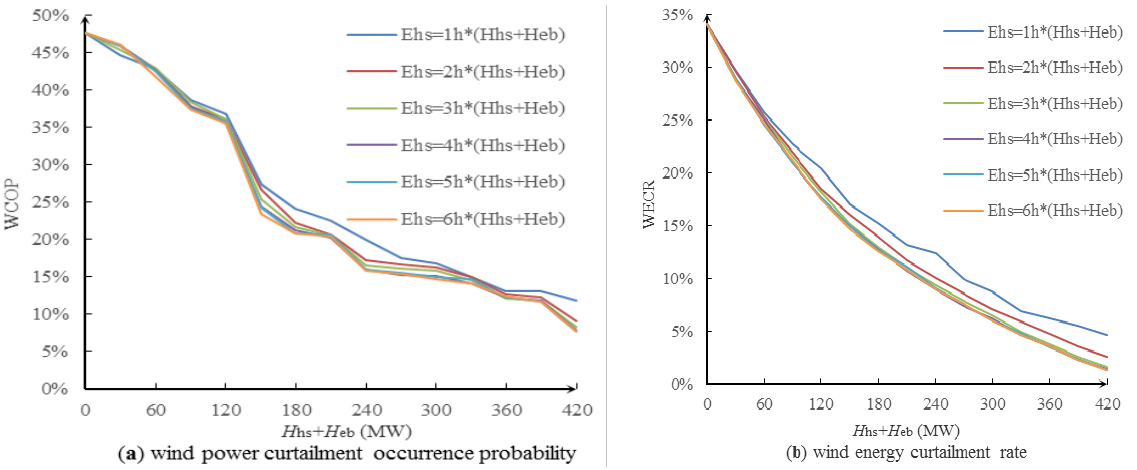
Figure 11. The simulation results of WCOP and WECR.